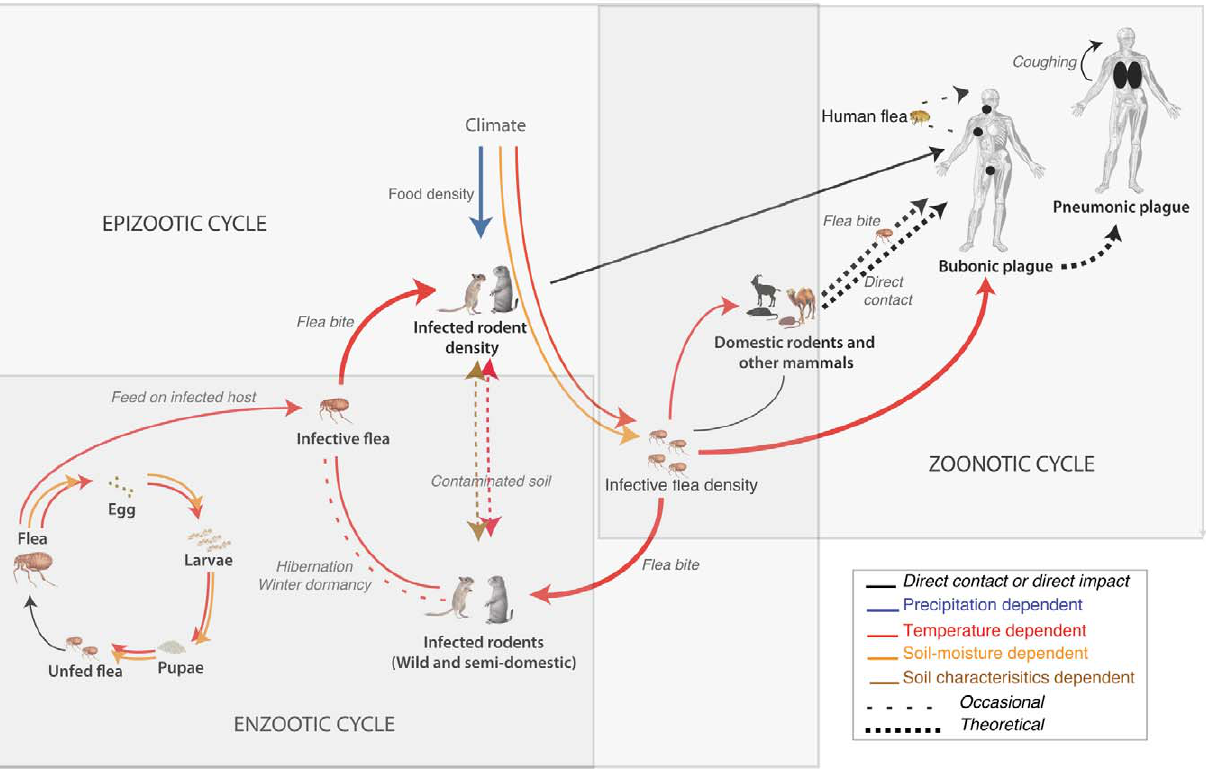
Figure 1. Schematic of the plague cycle with small mammals as hosts and fleas as vectors. Arrows represent connections affected by climate with a color-coding depending on the most influential climate variable on this link (i.e., precipitation, temperatures, and other variables indirectly depending on them such as soil characteristics and soil moisture). Grey rectangles somewhat arbitrarily delimit epizootic, enzootic, and zoonotic cycles. Note that despite their location at the far end of the cycle, humans often provide the only available information on plague